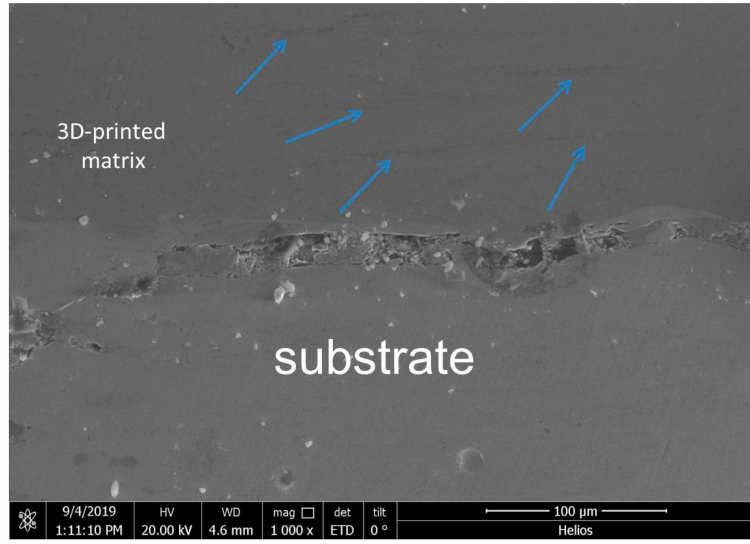
Figure 4. Distribution of crystalline phases in 3D-printed matrix.